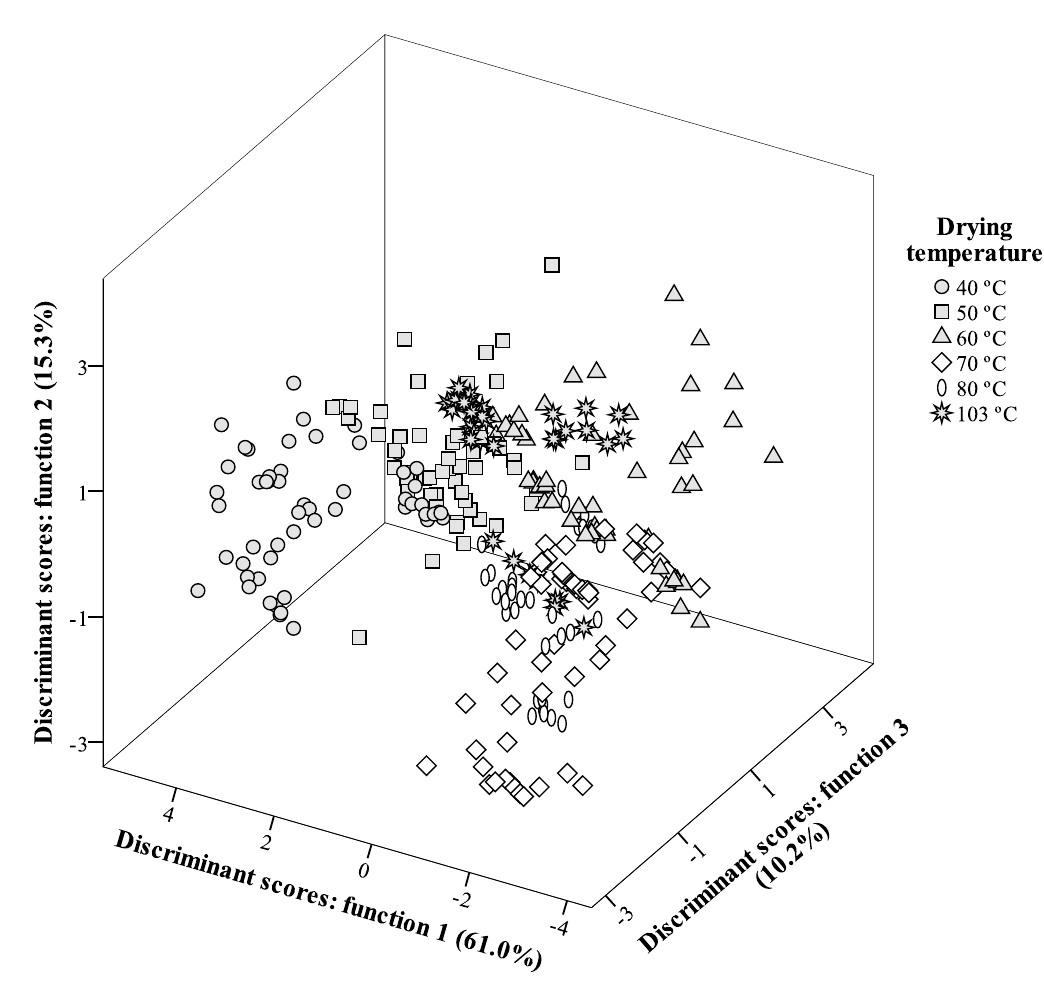
Figure 1. Spatial distribution of DT (drying temperature) and ES (extraction solvent) markers following the distribution set by the discriminant functions coefficients. Function 1 accounted for 61.0% of the variation, function 2 accounted for 15.3%, while function 3 accounted for 10.2%.